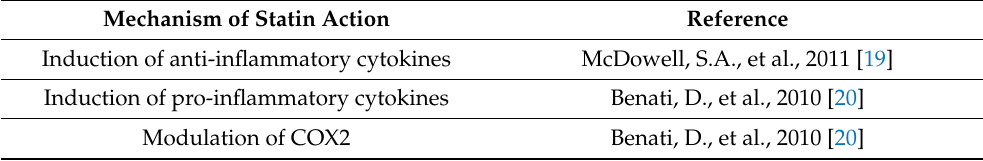
Table 1. Mechanism of statin action against intracellular Staphylococcus aureus (modified from [4]).